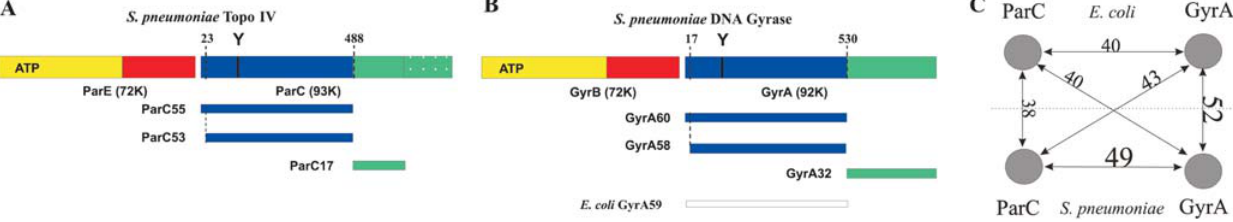
Figure 1. Comparison of type II topoisomerases from S. pneumoniae and E. coli . Schematic domain organization of (A) S. pneumoniae topoisomerase IV, (B) S. pneumoniae gyrase (with the proteolytic fragments generated by trypsin digestion superimposed) and (C) graphical representation of the sequence similarity scores for 500-residue N-terminal fragments of ParC (P72525) and GyrA (P72524) from S. pneumoniae and equivalent fragments of ParC (P0AFI2) and GyrA (P0AES4) from E. coli calculated using ClustalW [49].